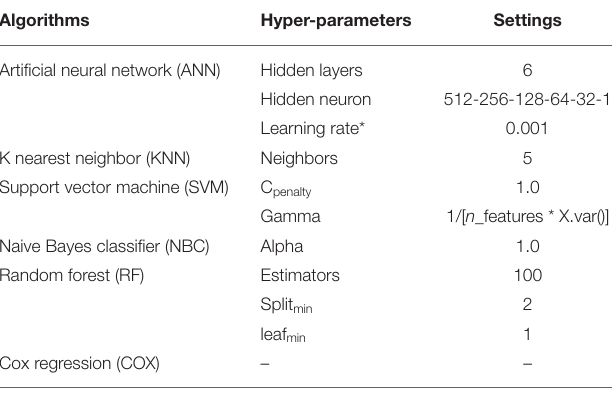
TABLE 4 | Hyper-parameters and final settings in all machine learning algorithms. Algorithms